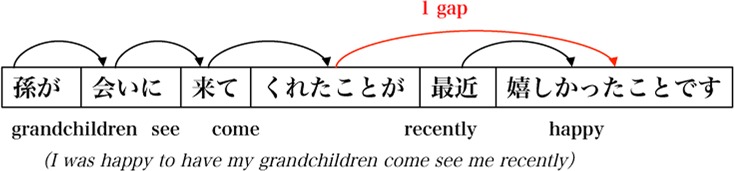
Dependency distance.